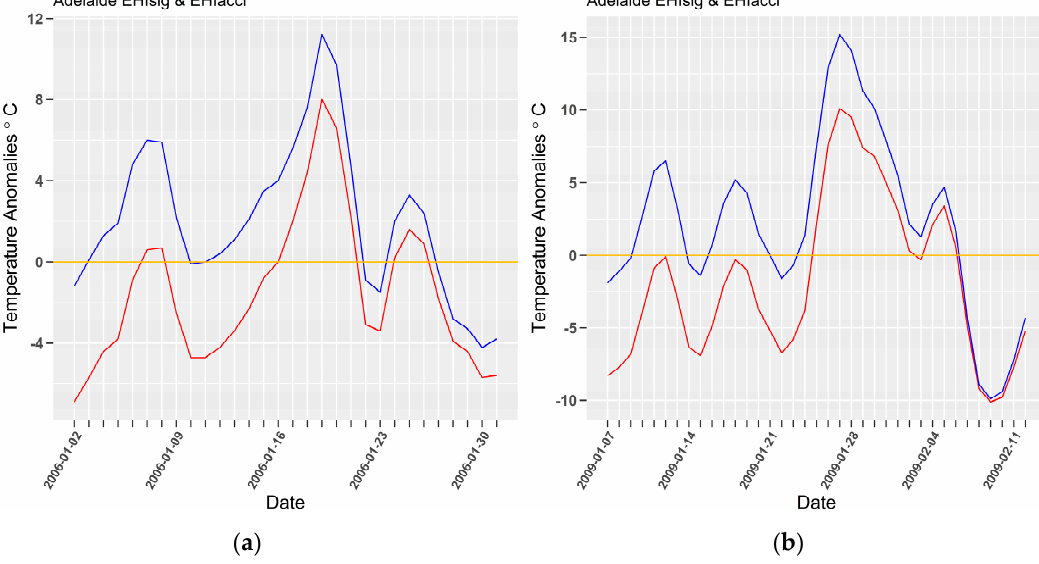
Figure A4. Acclimatization (blue) and significance (red) Excess Heat Indices for Adelaide’s 2006 ( a ) and 2009 ( b ) heatwaves, calculated using site data.